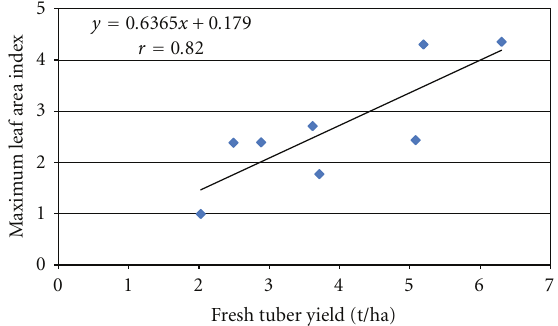
Figure 3: Relationships between the maximum leaf area index and the fresh tuber yield over the growing season of Dioscorea alata and D. rotundata grown with and without fertilizer application in a forest (fertile) and a savanna (infertile) sites in Central Cote d’Ivoire in